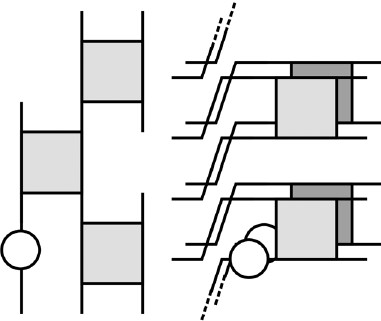
¯ Z ð ω ; t Þ ¯ Z ð s; t Þ 33. (a) and (b) for L ¼ 8 sites, as in Fig. 14 but here for the model with Heisenberg interactions, and with FIG. 35. Construction of j Tr ½ τ W ð t Þ(cid:2)j 2 for single-site observable J ¼ 1 = 4 . The legends in panels (a) and (b) show s and ω t= 2 π , τ , represented by an open circle. On the left, we show how τ respectively. appears within the circuit, and on the right, we illustrate how τ appears in the product of transfer matrices, which generates j Tr ½ τ W ð t Þ(cid:2)j 2 , here in the case where τ acts on a site x with x